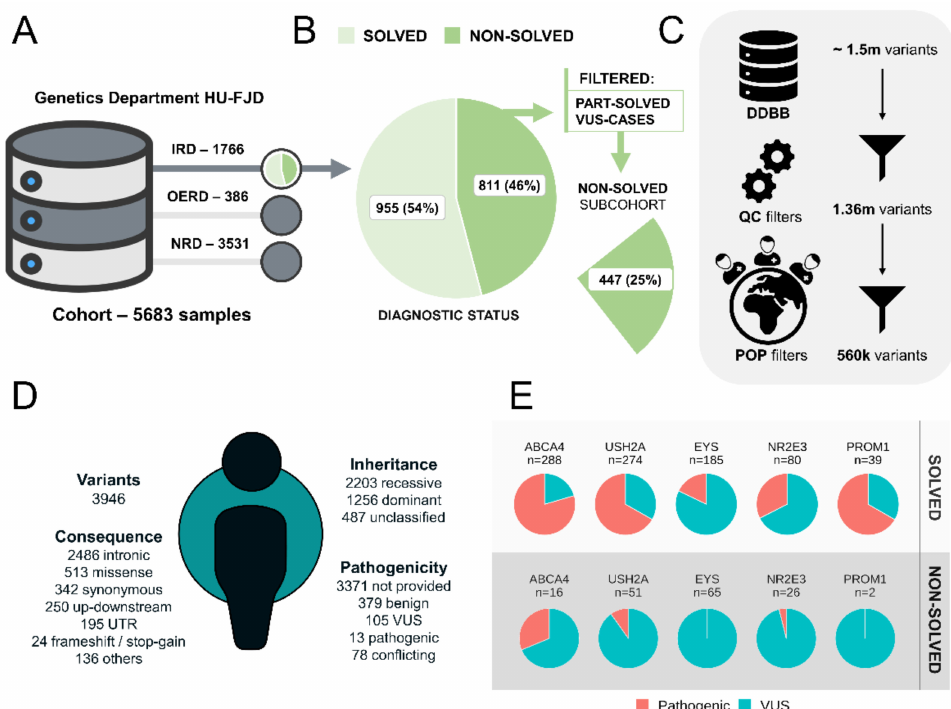
Figure 1. A heterogeneous cohort of rare diseases with the diagnostic status and variant composi- tion in IRD cases. ( A ) The cohort of patients with suspected rare genetic diseases at the Genetics Department of HU-FJD was divided into three subcohorts. An IRD subcohort of 1766 samples, other- eye-related diseases (OERD) of 386 cases, and a pseudocontrol subcohort of non-eye-related diseases (NRD) with 3531 samples. ( B ) IRD diagnostic status of the samples included in IRD subcohort was solved and non-solved. The subcohort of non-solved IRD cases with no candidate variants represent the 25%. C) Flow chart of different filters applied to variants according to quality control (QC) and population (POP) filters. ( D ) Summary of the variants included in the database in an average IRD case; values represent the average of all IRD samples. ( E ) Proportion of pathogenic and VUS variants detected in IRD cases in the genes with more pathogenic variants in IRD solved cases; top 5 genes are